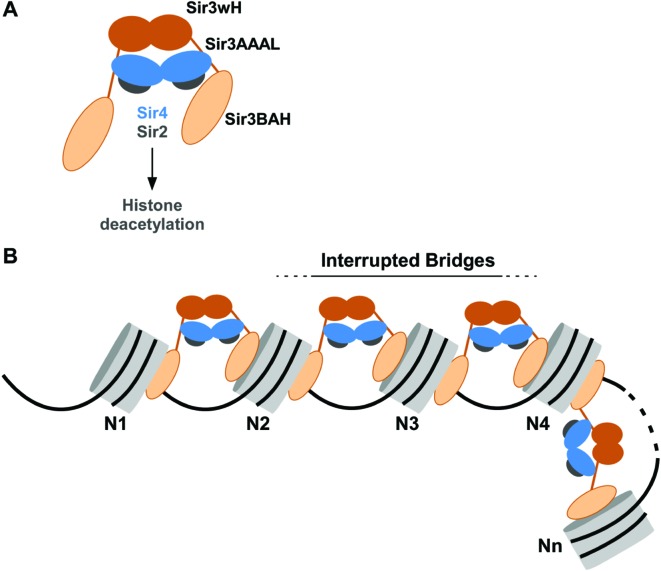
Association of the SIR complex with chromatin by interrupted Sir3 bridges across neighboring nucleosomes.(A) Schematic of the SIR complex indicating the location of domains in Sir3 (brown) and Sir4 (blue) dimers, and highlighting the interaction of Sir4 with Sir2. Not to scale. (B) Model for the association of the SIR complex with chromatin. Sir3 dimers form inter-nucleosomal bridges via cooperative association with histone H4K16 and H3K79 regions on flat nucleosome surfaces. The Sir3 bridge requires the wH domain and is further stabilized via interactions between the coiled-coil domain of Sir4 and the AAAL domain of Sir3. Spreading does not involve interaction of newly recruited Sir3/Sir4 with already bound complexes but instead requires cooperative association with a pair of H4K16 deacetylated and H3K79 unmethylated nucleosome surfaces, and thus is driven primarily by Sir2-dependent deacetylation of proximal nucleosomes. The inability of Sir3 to simultaneously interact with binding sites on the same nucleosome, requires spreading via the formation of interrupted Sir3 bridges. Sir3 may interact with immediately neighboring nucleosomes (N1 and N2, N2 and N3, N3 and N4) or more distal nucleosome pairs lacking H4K16ac/H3K79me modifications (N4 and Nn).